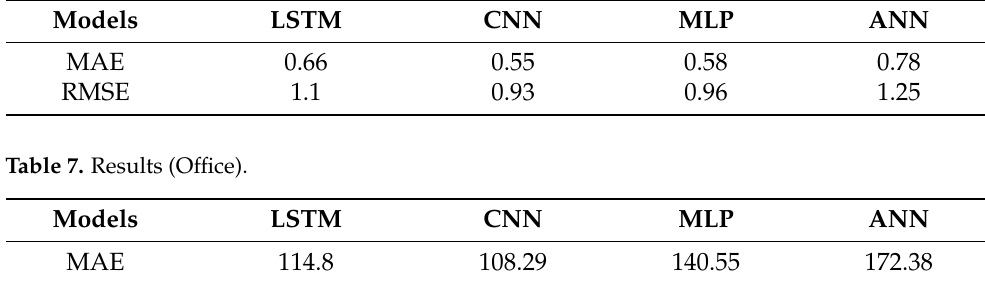
Table 6. Results (Household).